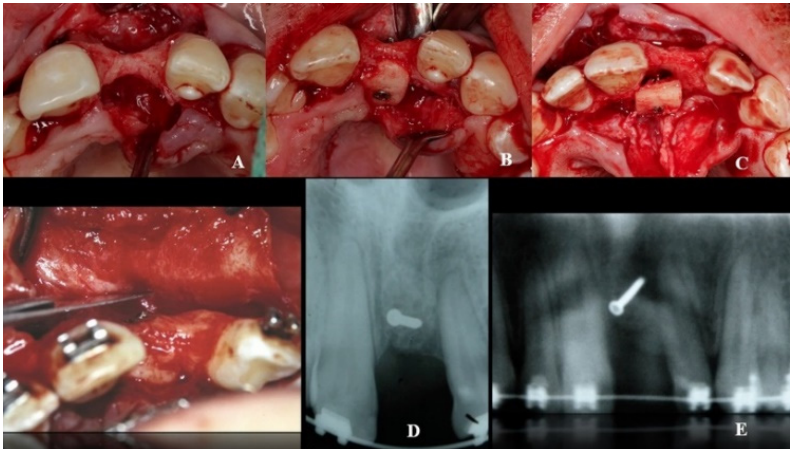
Figure 4. Recipient area ( A ). Location of the bone block at the level of the foramen incisive ( B ) and on its incisal aspect ( C ). ( D,E ) Block fixation using fixing